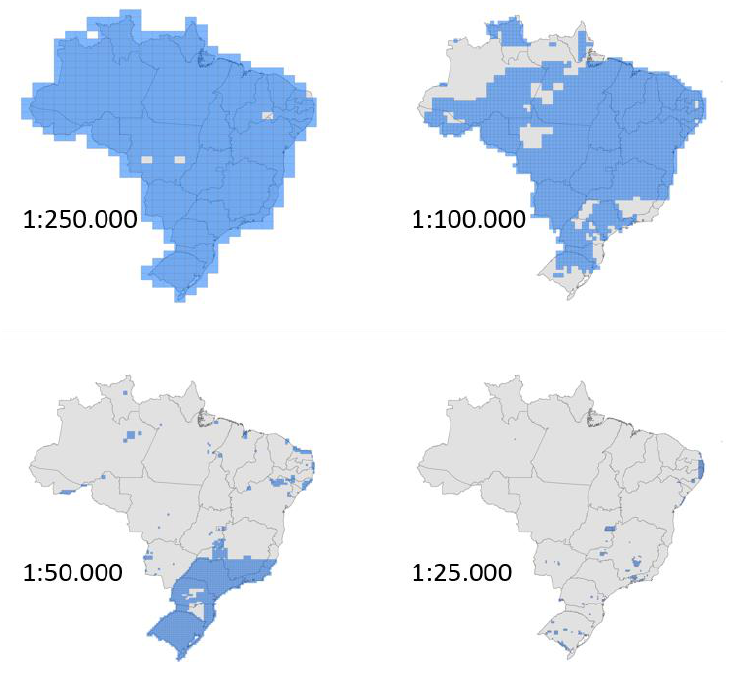
Figure 1. Map coverage in Brazil by scales. Adapted from Picanço Jr. and Delazari